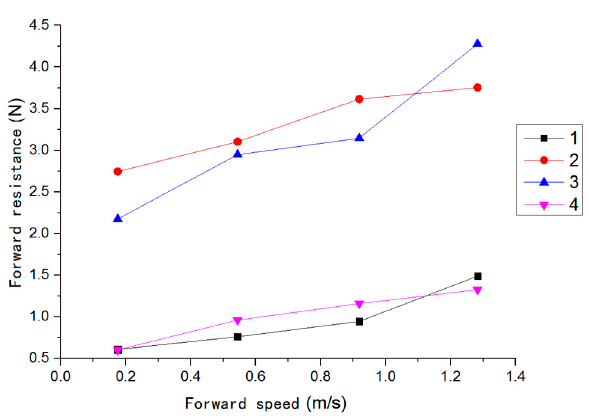
Figure 14. Relationship between forward resistance and forward speed.